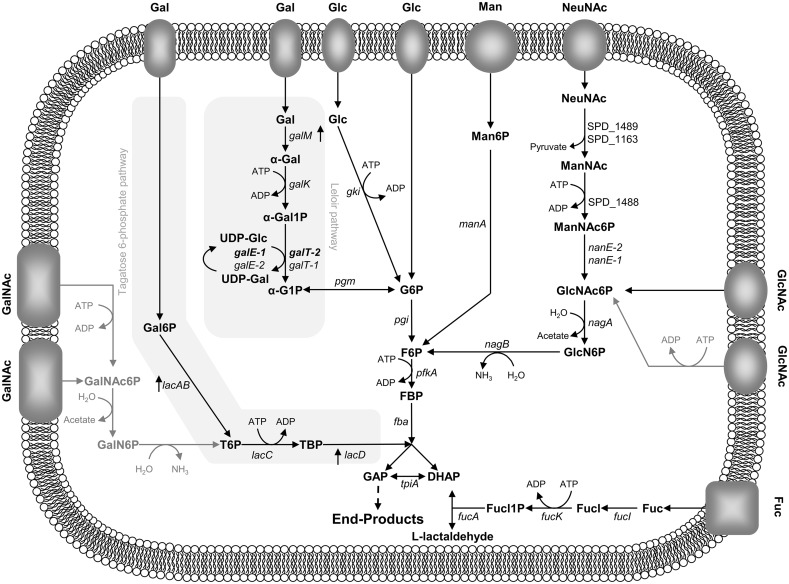
Schematic representation of the proposed pathways for the dissimilation of monosaccharides originating from deglycosylation of host glycans in S. pneumoniae D39.Pathways were reconstructed resorting to metabolic databases (MetaCyc and KEGG), genome annotations at NCBI and literature. Genes and intermediates involved in the galactose (Gal), mannose (Man), N-acetylneuraminic acid (NeuNAc), N-acetylgalactosamine (GalNAc), N-acetylglucosamine (GlcNAc) and fucose (Fuc) catabolism are shown. Initial steps of glycolysis are depicted. galM, aldolase 1-epimerase; galK, galactokinase; galT-1, galT-2, galactose 1-phosphate uridylyltransferase; galE-1, galE-2, UDP-glucose 4-epimerase; pgm, phosphoglucomutase/phosphomannomutase family protein; lacA, galactose 6-phosphate isomerase subunit LacA; lacB, galactose 6-phosphate isomerase subunit LacB; lacC, tagatose 6-phosphate kinase; lacD, tagatose 1,6-diphosphate aldolase; manA, mannose 6-phosphate isomerase; SPD_1489, SPD_1163, N-acetylneuraminate lyase; SPD_1488, ROK family protein, nanE-1, nanE-2, N-acetylmannosamine 6-phosphate 2-epimerase; nagA, N-acetylglucosamine 6-phosphate deacetylase; nagB, glucosamine 6-phosphate isomerase; fucI, L-fucose isomerase; fucK, L-fuculose kinase; fucA, L-fuculose phosphate aldolase. α-Gal, α-galactose; α-Gal1P, α-galactose 1-phosphate; α-G1P, α-glucose 1-phosphate; UDP-Glc, UDP-glucose; UDP-Gal, UDP-galactose; Gal6P, galactose 6-phosphate; T6P, tagatose 6-phosphate; TBP, tagatose 1,6-diphosphate; Man6P, mannose 6-phosphate; ManNAc, N-acetylmannosamine; ManNAc6P, N-acetylmannosamine 6-phosphate; GlcNAc6P, N-acetylglucosamine 6-phosphate; GlcN6P, glucosamine 6-phosphate; Fucl, fuculose; Fucl1P, fuculose 1-phosphate; GalNAc6P, N-acetylgalactosamine 6-phosphate; GalN6P, galactosamine 6-phosphate. The upper glycolytic intermediates and gene annotations are as follows: G6P, glucose 6-phosphate; F6P, fructose 6-phosphate; FBP, fructose 1,6-biphosphate; GAP, glyceraldehyde 3-phosphate; DHAP, dihydroxyacetone phosphate. gki, glucokinase; pgi, glucose 6-phosphate isomerase; pfkA, 6-phosphofructokinase; fba, fructose-biphosphate aldolase; tpiA, triosephosphate isomerase. The lower glycolytic pathway is represented by a dashed arrow. Pathways or steps present in other organisms but uncertain in D39 are represented in grey. Vertical arrows near the gene name indicate the upregulation during growth on mucin as compared to Glc, in S. pneumoniae D39.